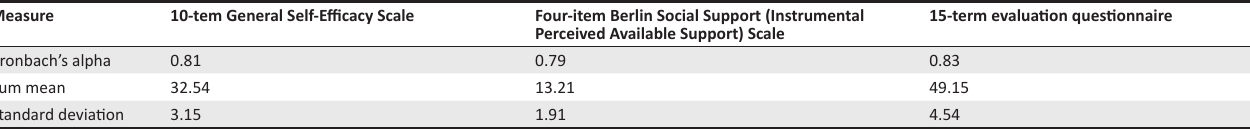
TABLE 5: Descriptive statistics for outcomes evaluation questionnaire subscales. Measure 10-tem General Self-Efficacy